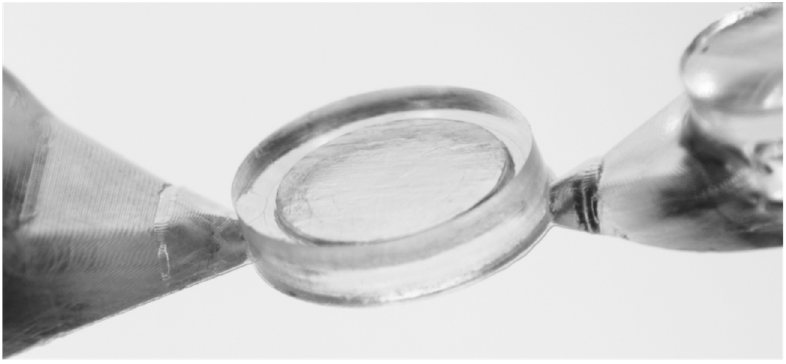
Figure 18. Injection-molded encoder disc with blazed grating.